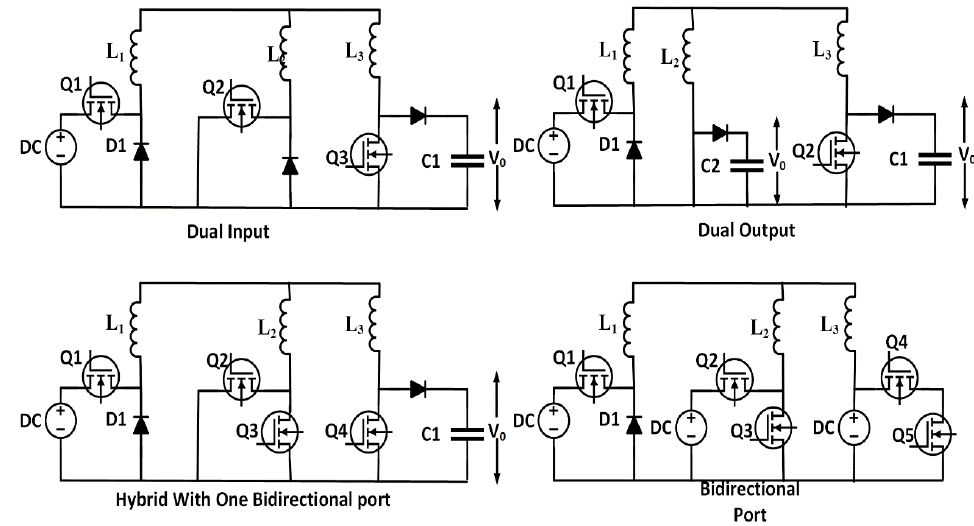
Figure 23. NI three-port buck–boost Converters.